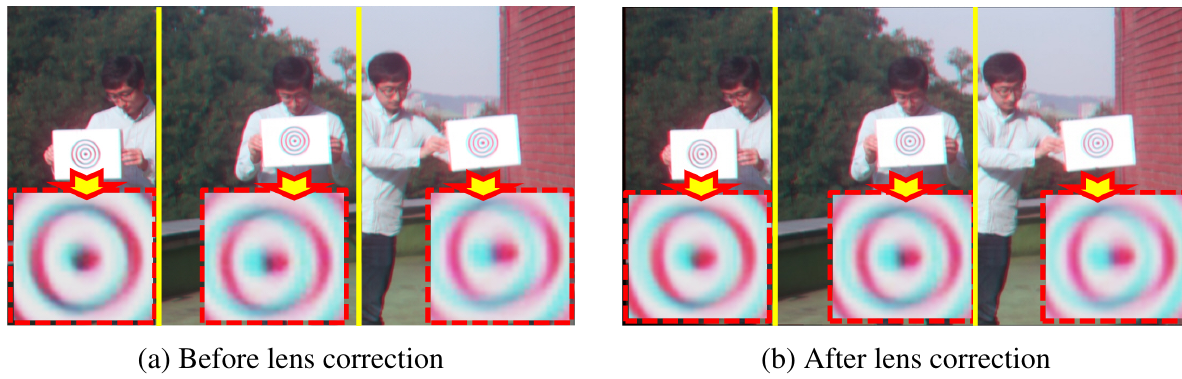
Figure 5. The result of the lens distortion correction. ( a ) Before lens correction; ( b ) After lens correction.